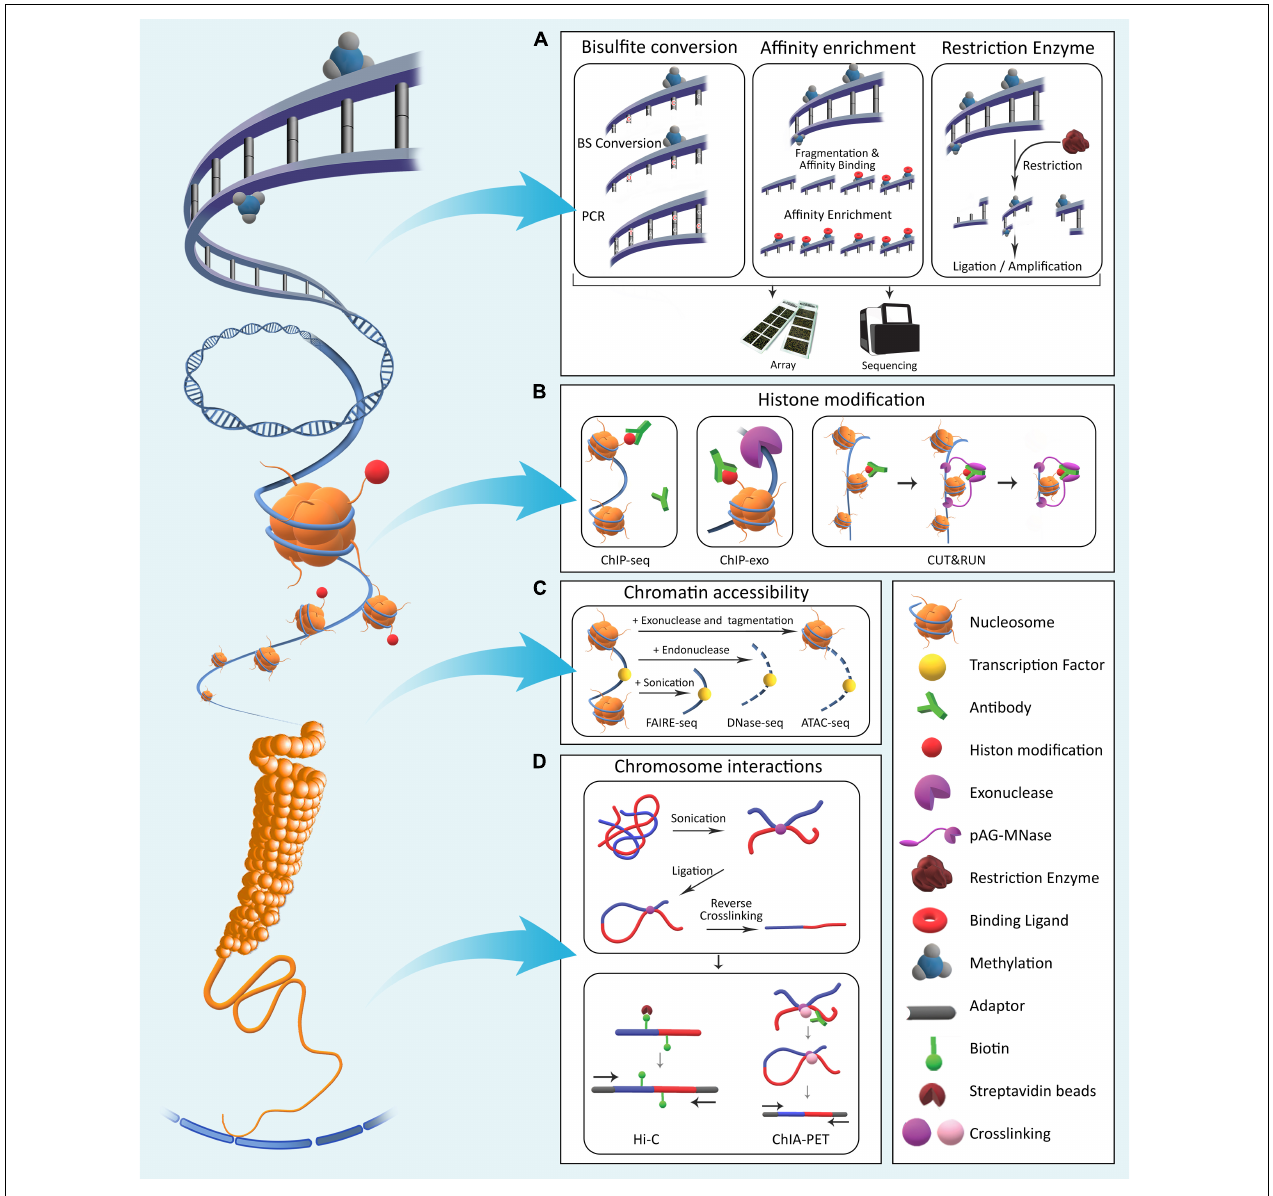
FIGURE 1 | The four major epigenetic layers in Eukaryotic genomes. (A) DNA methylation involves direct chemical addition of a methyl group to certain bases in DNA. Methods for assessment of genome-wide DNA methylation are broadly categorized into bisulfite conversion-based, affinity enrichment-based, and restriction enzyme-based techniques. (B) Histones undergo a variety of chemical modifications on their tail domains. Methods for detection of these modifications rely on antibodies specifically designed to bind modified histone tails for immunoprecipitation with varying levels of resolution. (C) Genomic regions differ with respect to nucleosome occupancy and accessibility of DNA molecule to proteins. Various methods have been developed that quantify these characteristics across the genome. (D) Long-range interactions exist between regulatory elements across the genome. To identify and characterize them in a genome-wide fashion, various methods based on crosslinking and ligation have been developed with varying levels of coverage and specificity ( Table 1